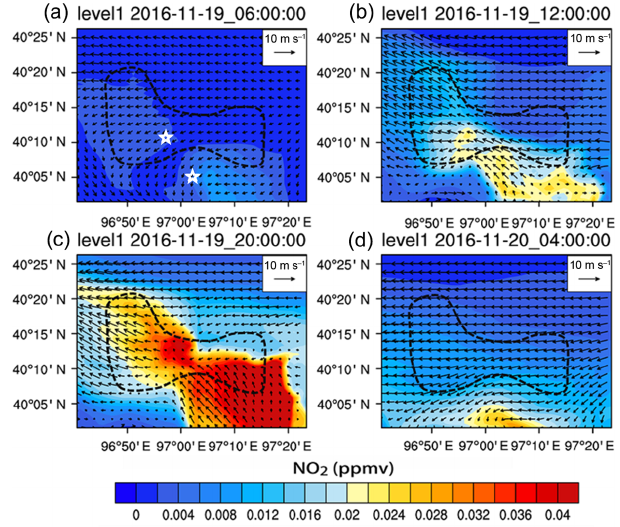
Figure 3. WRF-Chem simulated hourly NO 2 air concentrations (ppmv) and vector winds at the first model level above the sur- face ( ∼ 10m) at 06:00, 12:00, and 20:00UTC, 19 November, and 04:00UTC, 20 November, in the fine domain (d03) from the control run (S1). The YWF is encircled by the black dashed line. Two white stars highlight two model grids at which the modeled NO 2 vertical profiles within and outside the YWF are compared (Figs. 11 and 13 and corresponding discussions). The one grid (44, 52) is located within the wind farm and the other one (50,48) is located outside the YWF. The magnitude of reference wind speed at 10ms − 1 is shown in the upper-right panel.